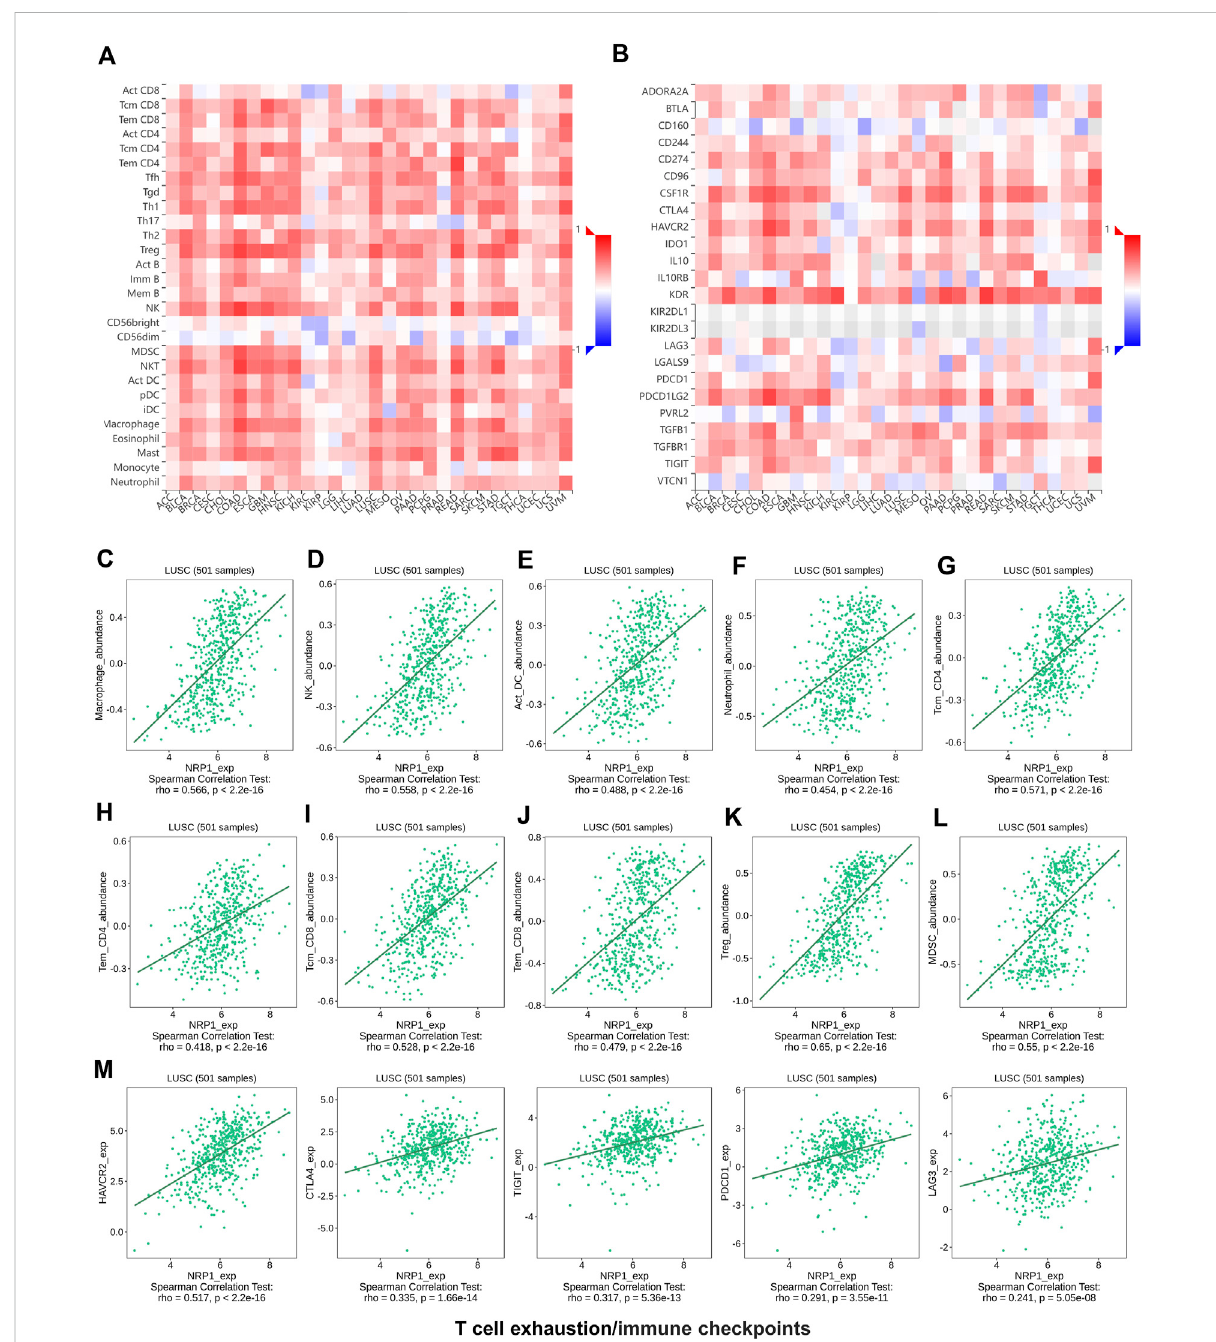
The relationship analysis between NRP1 expression and tumor immune environment using the TISIDB database (A) The relation between NRP1 expression and the abundance of different kinds of TILs in various cancers. (B) The relation between NRP1 expression and the expression of various immunoinhibitory markers across cancers (C-L) The correlation between NRP1 expression and the abundance of macrophages, NK cells, activatedDCs, neutrophils,TcmCD4 + cells, TemCD4 + cells, TcmCD8 + cells, TemCD8 + cells, Tregs, andMDSCsinLUSC,respectively. (M) The correlation between NRP1 expression and the expression of HAVCR2, CTLA4, TIGIT, PDCD1, and LAG3 in LUSC,